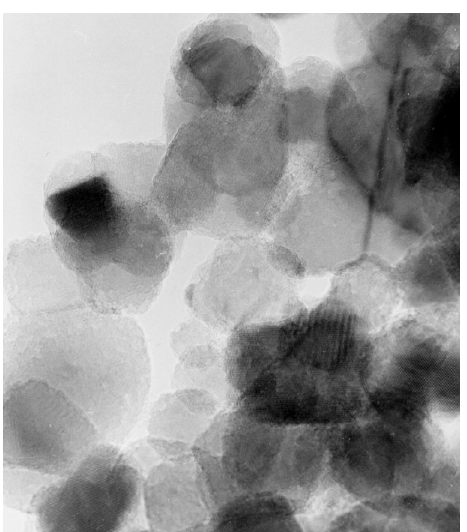
Figure 3. TEM image of the commercial titania P25 photocatalyst (Degussa) showing particles with sizes ranging from 10 to 40 nm.